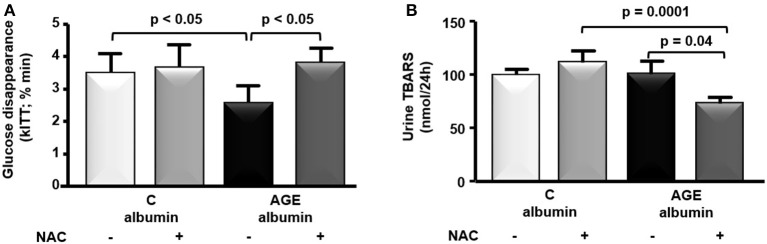
Insulin tolerance test and urine thiobarbituric acid reactive substances (TBARS). (A) At the end of the protocol, insulin tolerance test (ITT) was performed in animals treated with C-albumin (n = 3), C-albumin + NAC (n = 4), AGE- albumin (n = 4), and AGE-albumin + NAC (n = 4). Blood samples were collected from the tail vein 0, 4, 8, 12, and 16 min after an intravenous injection (penis vein) of regular insulin (100 UI/mL/kg) and glucose disappearance constant (kITT; % min) was determined. (B) TBARS (nmol/24 h), markers of lipid peroxidation, were determined in 24-h urine samples at the end of the protocol in C (n = 6), C + NAC (n = 5), AGE (n = 6), and AGE + NAC (n = 5) groups. The optical density was read at 534 nm. Results (mean ± SEM) were compared by One-way ANOVA with Newman-Keuls post-test.